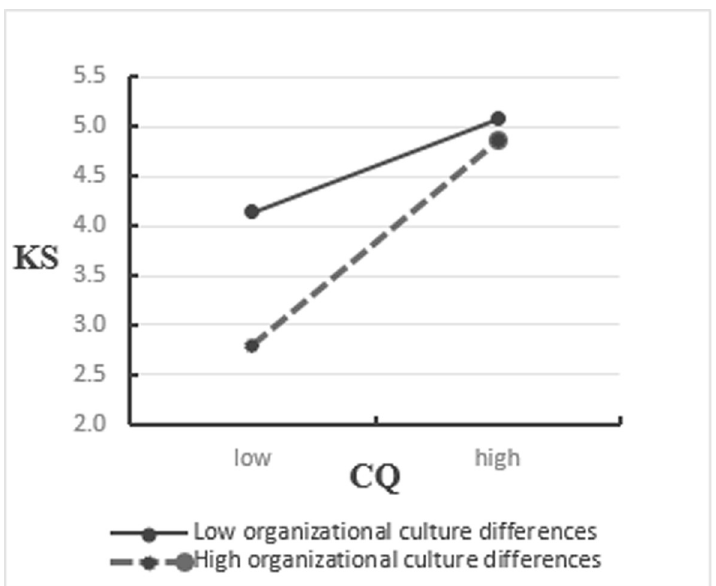
Fig 3. Test of the moderating effect of organizational cultural differences on CQ and knowledge